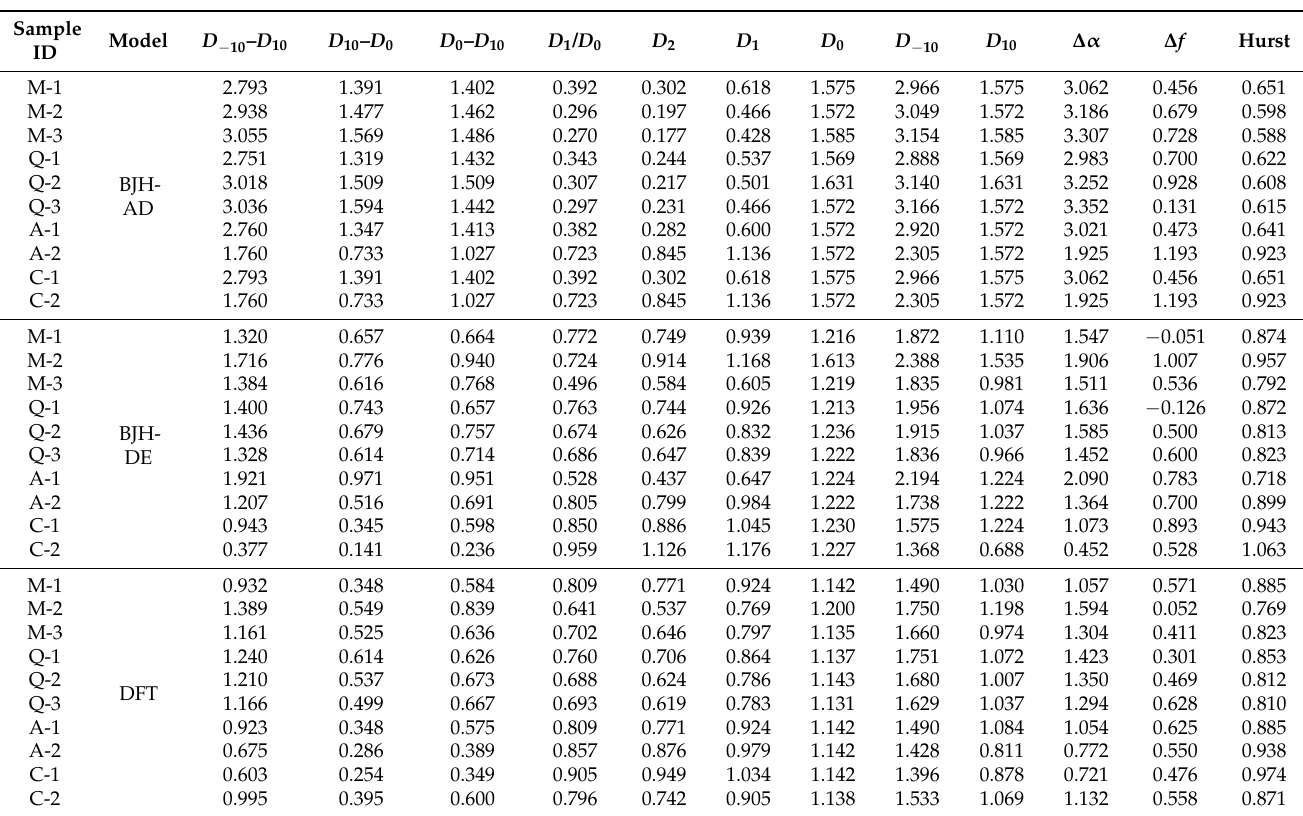
Table 4. Multifractal analysis results of the samples using BJH-DE, BJH-DE, and DFT